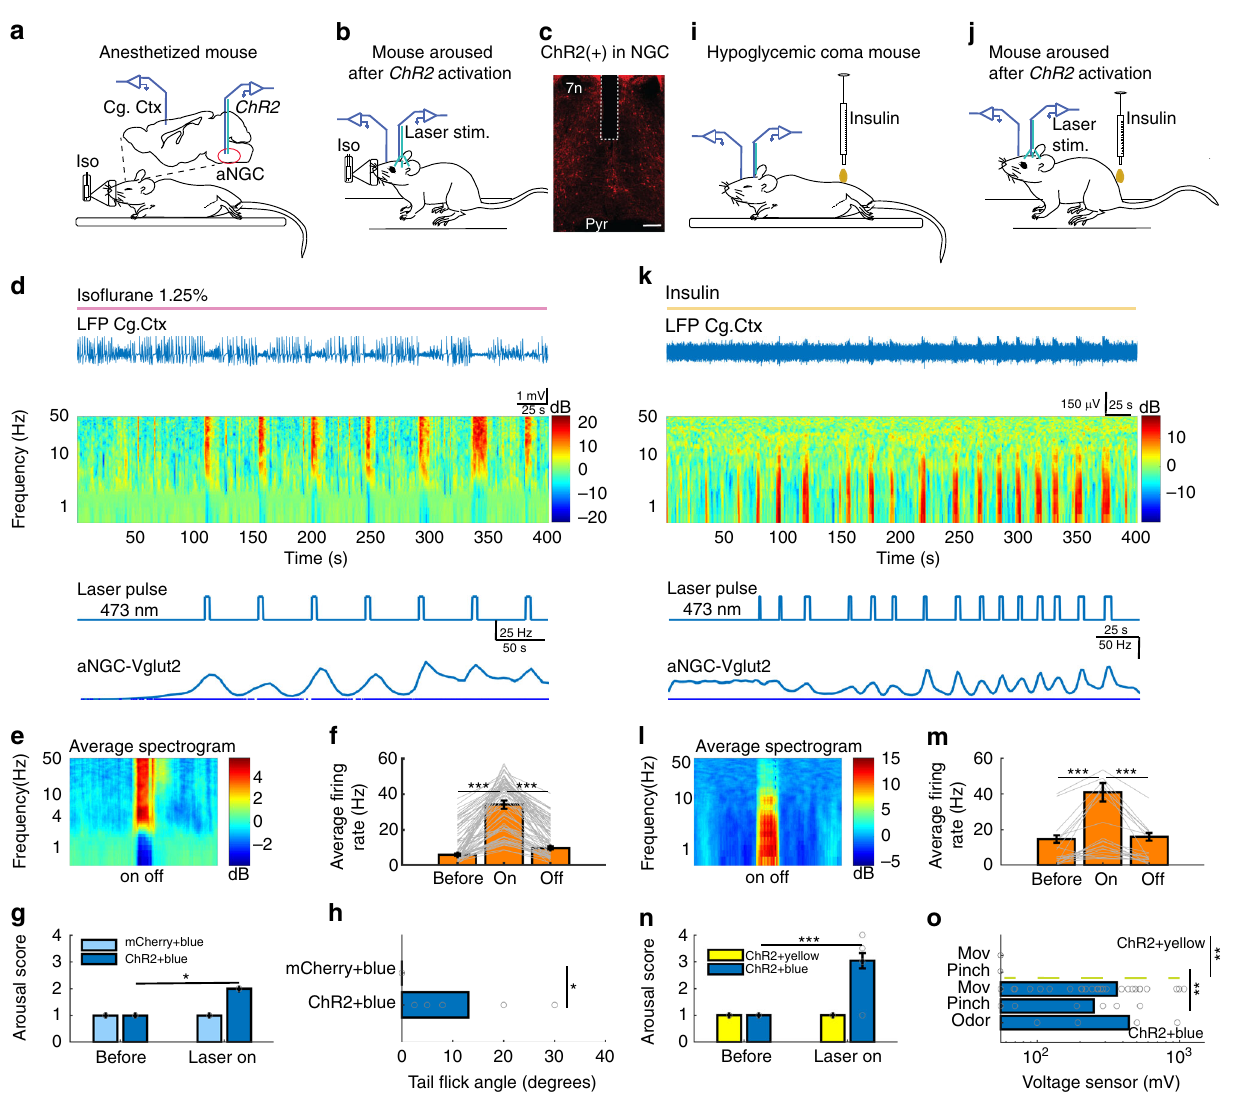
Fig. 2 Optogenetic stimulation of aNGC-Vglut2 + cells induces arousal. a Schematic shows injection area of AAV-packaged Cre -inducible light-gated cationic ion channel in aNGC and location of LFP electrodes in the cingulate cortex and optic fi ber placement for stimulation in aNGC in a sagittal mouse brain section. b Schematic depicts an anesthetized mouse (iso fl urane 1.25% vol) optogenetically stimulated. c Fluorescence image of aNGC showing location of optic fi ber in a Vglut2- Cre mouse injected with AAV expressing ChR2- mCherry (red). Scale bar: 200 µ m. 7n, seven nerves; Pyr, pyramidal tract. ChR2-mCherry was expressed within ~600 µ m from injection site. d LFP (raw data) and spectrogram plotted as the difference from the temporal mean showing increases in high frequencies and decreases in low frequency cortical oscillations (< 4 Hz) in phase with photostimulation (5s-30 Hz stimulation). Color bar represents power in decibels. LFP transitions abruptly to a desynchronized state with each photostimulation. Note, the recruitment of fi ring of a Vglut2 + aNGC neuron occurred during photostimulation in PIC (iso fl urane 1.25%). e Average spectrogram of 135 laser pulses aligned to laser onset. f Mean fi ring rates (mean ± s.e.m.) of aNGC cells ( n = 21) before, during photostimulation (on) and after laser ceased (off) *** p = < 0.001 (one-way ANOVA). g Quanti fi cation of arousal score and tail movement. h Before and after laser stimulation in animals expressing ChR2 or mCherry. Kolmogorov – Smirnov test (KST), * p = < 0.05. i , j Schematic of hypoglycemic-comatose mouse before and after a 5 s laser stimulation. A prolonged stimulation promoted a full right up posture. k LFP and spectrogram while performing optogenetic stimulation. Each laser pulse increased power in all frequencies with movement of tail and limbs (see Supplementary Video 2) and modulated glutamatergic cells ( k , m ). l Power spectral density using total power from over 33 laser pulses aligned to laser onset. m Firing rate (mean ± s.e.m.) of aNGC cells ( n = 3) before and after laser onset *** p = < 0.001 (one-way ANOVA). n Arousal score and sensor responses ( o ) obtained after laser stimulation using yellow light ( n = 32) and blue light ( n = 30). Animals show strong responses after noxious stimulation (pinch; n = 6) and smell (odor; n = 5) 2 s after laser stimulation ended. KST, *** p < 0.001and ** p < 0.01. Source data are provided as a Source Data fi